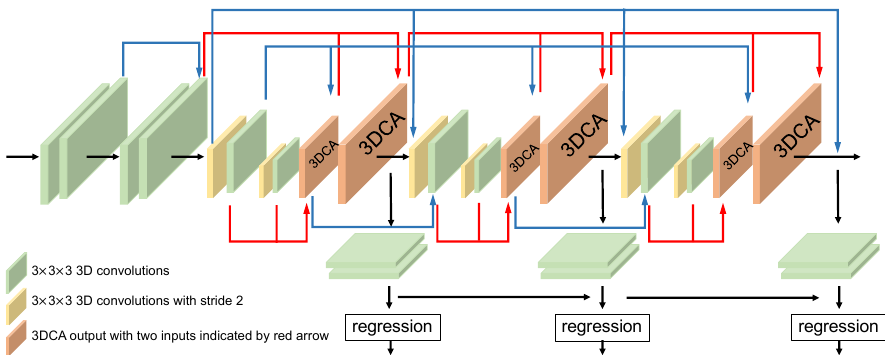
Figure 5. Our 3D Context-guided Attention Network (3DCAN). 3DCAN is based on stacked hour- glass architecture. The input is 4D cost volume, and the output is three disparity estimations. The blue arrows represents adding up the connected feature maps. The 3DCA feature map is obtained by combining the two foregoing feature maps with the 3DCA module, as indicated by the red